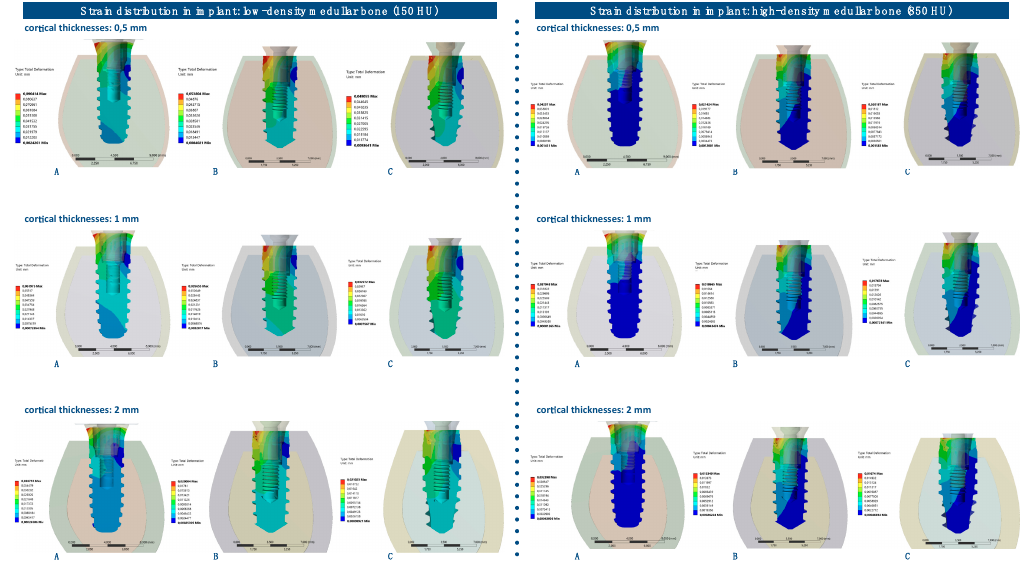
Figure 8. Strain distributions in implants for all implant designs: A, B, and C. Note: the figure is in very high resolution to be able to be enlarged: enlarge it in your word processor or view it in HTML format.